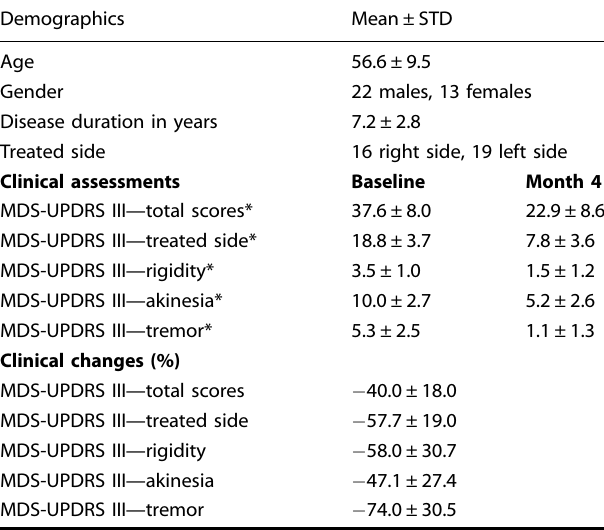
Table 1. Demographics and clinical assessments of 35 patients with PD. All the clinical assessments were done in off-medication state. Rigidity, akinesia, and tremor scores are corresponding to the treated